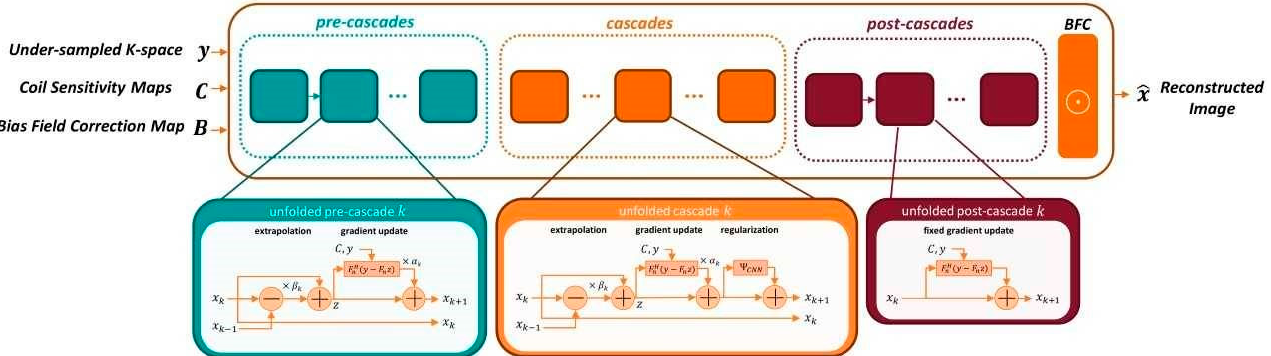
Figure 2. Architecture of the fixed iterative reconstruction scheme. Pre-cascades address data consistency and generate an image similar to conventional parallel imaging, cascades use an alternating scheme between data consistency and regularization, post-cascades reemphasize consistency of a reconstructed image and acquired data. Note that only the regularization is a Convolutional Neural Network (CNN). Nevertheless, the whole architecture can be presented by a general network.